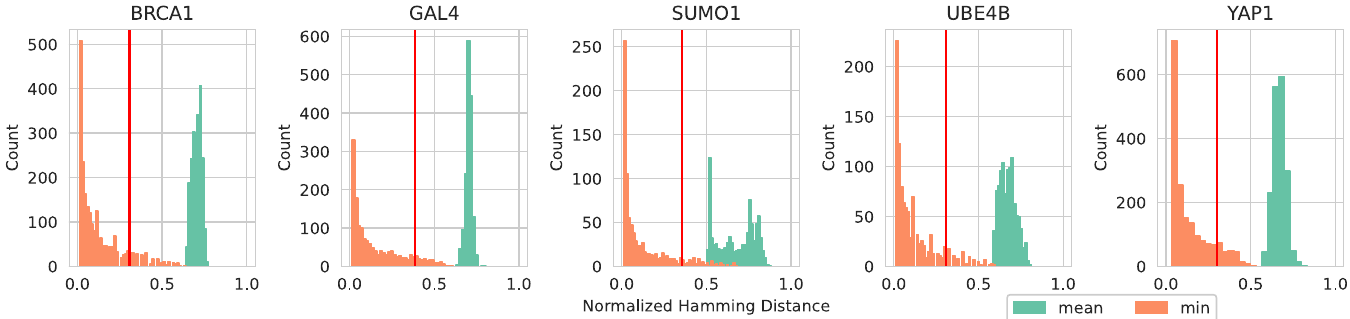
Fig 2. Normalized Hamming distance from test to train datasets. Shown are mean (green) and minimum (orange) distances from every test sequence to the sequences in the training set. The normalized Hamming Distance is the number of differing amino acids between two sequences, divided by the sequence length. The red bar indicates the distance at which the test set is divided in a ratio 9:1 with respect to the minimum distance to the training set.